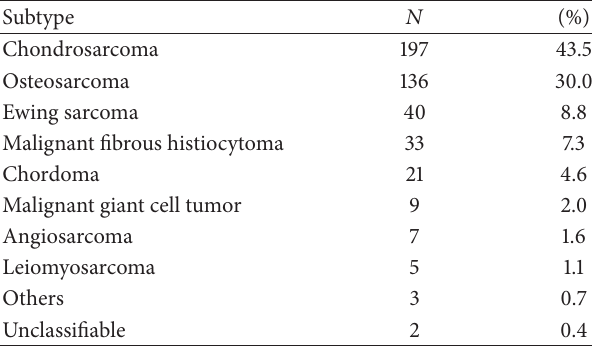
Table 4: Histological subtypes in adult bone sarcoma patients treated at the Sarcoma Centre of Aarhus University Hospital from 1979 to 2008 (𝑁 = 453)